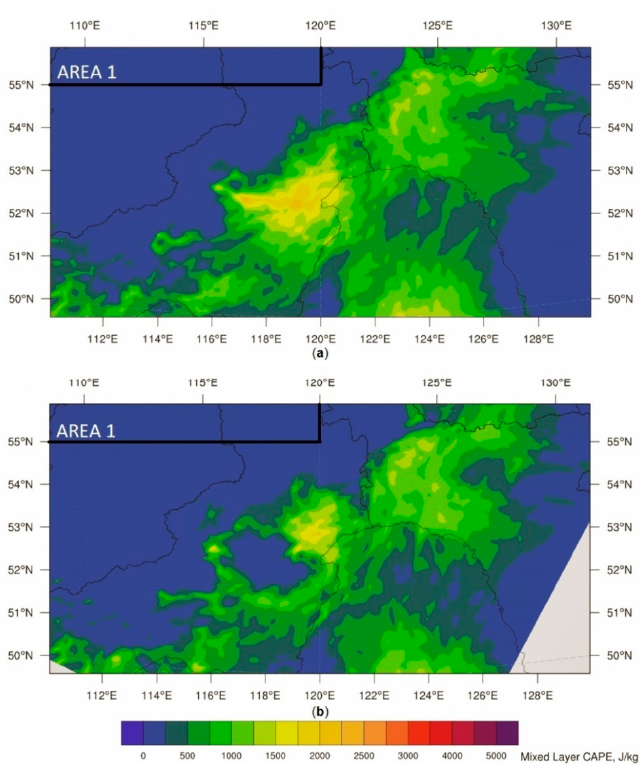
Figure 7. Spatial distributions of MLCAPE index within the area with intensive convection for: ( a ) control experiment and ( b ) ART experiment.